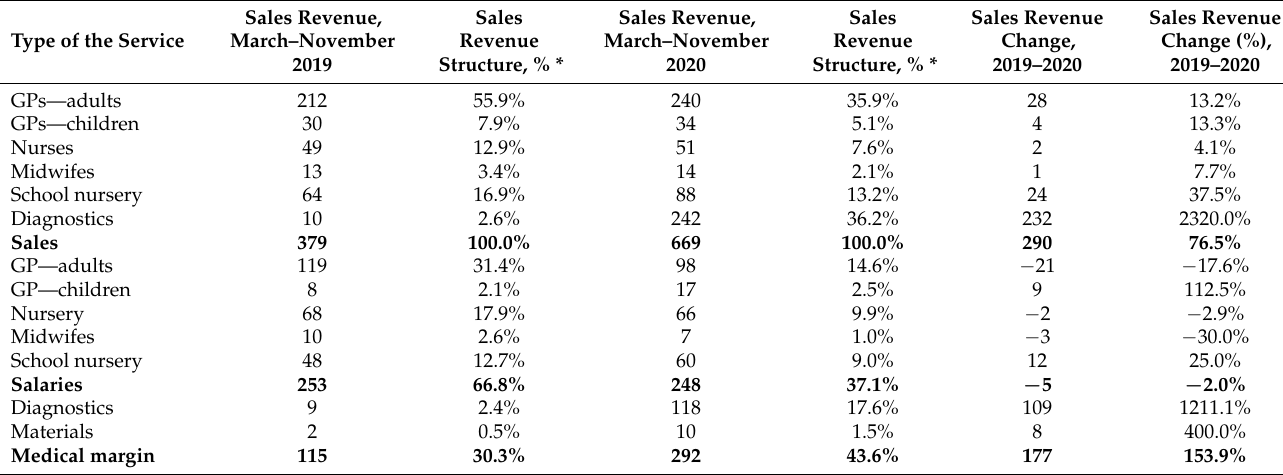
Table 3. Financial indicators of Clinic 1 in March–November 2019 and March–November 2020. All amounts in EUR thousand.